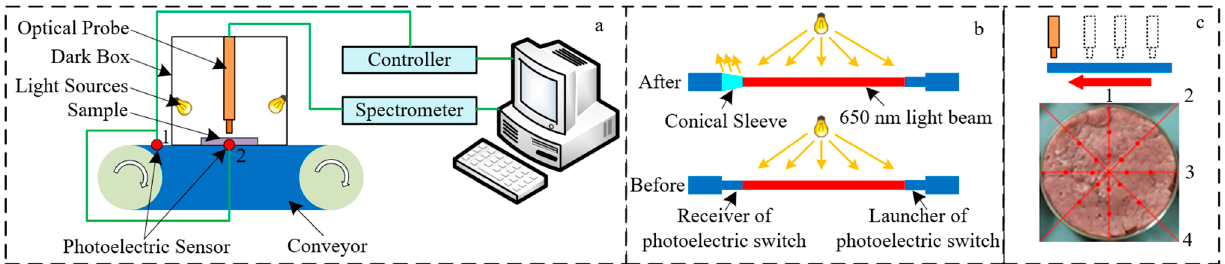
Figure 1. Schematic diagrams of the ( a ) online NIRS system, ( b ) method for avoiding the interference, and ( c ) data acquisition. The input current is converted into an optical signal and emitted by a laser photoelectric switch. The receiver detects the target object according to the intensity of the received light or whether there is no light. A conical sleeve is installed on the receiver of the laser photoelectric switch, which is mainly used to avoid the interference of the light emitted by the light source to the receiver.